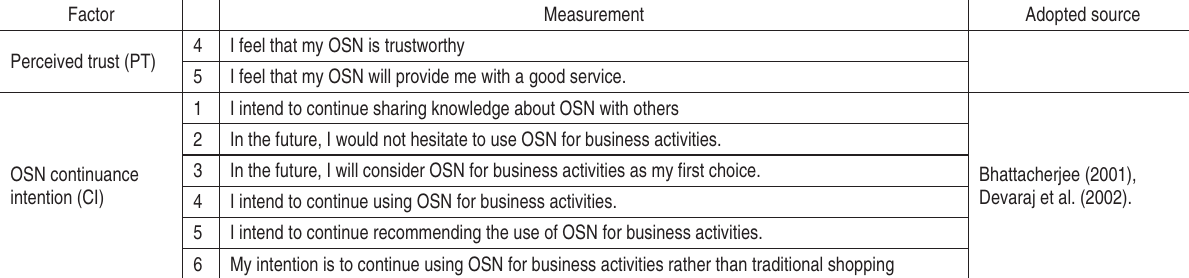
Table 1 (cont.). Operationalization of psychosocial factors influencing OSN continuance